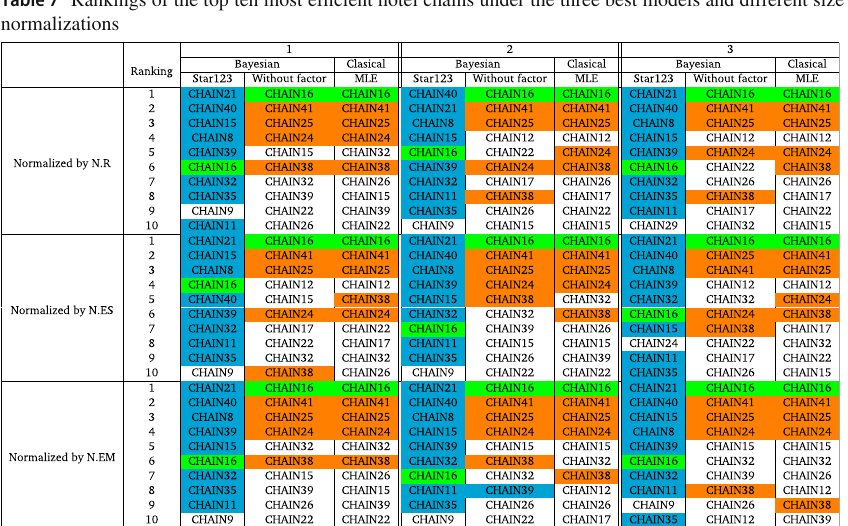
Green = top ranking chains under all models and size normalizations with and without the inclusion of exogenous variables. Orange = top ranking chains when exogenous variables are not included. Blue =